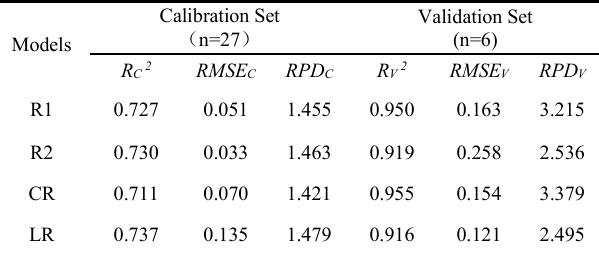
Table 5. Comparison of accuracy of SLR regression inversion models for the salt content of mural